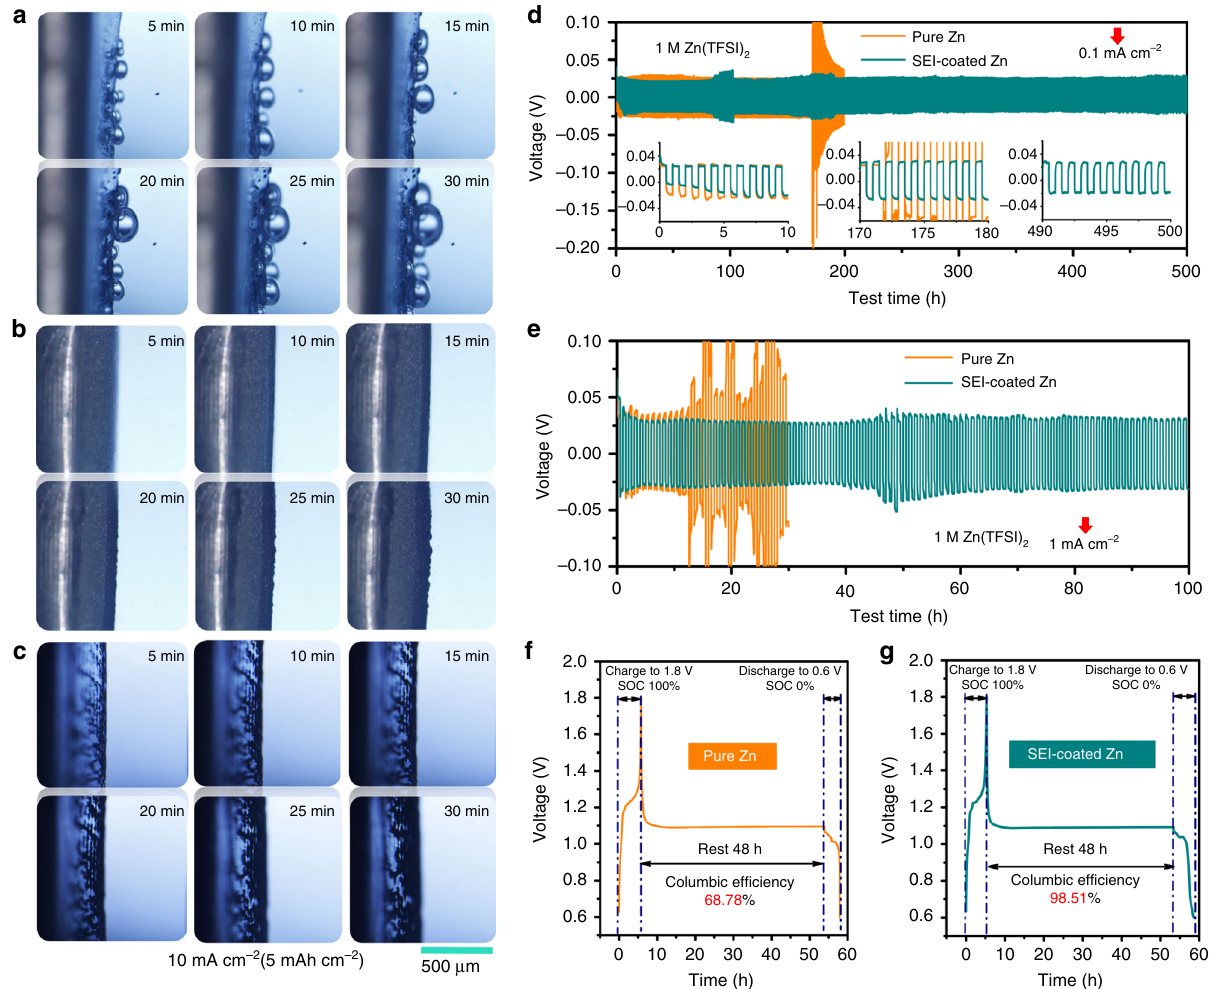
Fig. 5 The validity of the SEI layer for Zn electrochemistry. a – c In situ investigations of the Zn deposition by optical microscopy in Zn/Zn cells. Images of the Zn-electrolyte interface region in a 1 M Zn(TFSI) 2 and b ZES. c Images of SEI-coated Zn-electrolyte interface region using 1 M Zn(TFSI) 2 . The deposition current density is 10 mA cm − 2 with the areal capacity of 5 mAh cm ‒ 2 . Galvanostatic cycling performance of symmetric Zn/Zn cells tests using pure and SEI-coated Zn coupled with 1 M Zn(TFSI) 2 at d low rate of 0.1 mA cm − 2 (0.05 mAh cm − 2 for each half cycle) and e high rate of 1 mA cm − 2 (0.5 mAh cm − 2 for each half cycle). The Zn/V 2 O 5 cells in 1 M Zn(TFSI) 2 using f pure Zn anode and g SEI-coated Zn anode were fi rst fully charged to 1.8 V at 20 mA g − 1 (based on active materials of cathode), respectively, and then the cells were rested at 100% stage of charge (SOC) for 48 h, followed by full